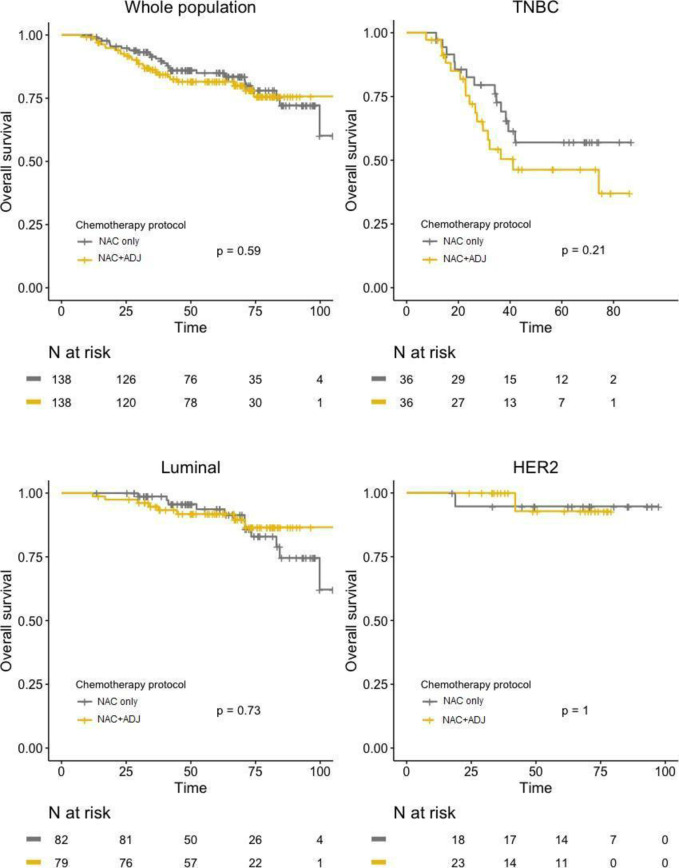
OS curves in NAC only and NAC+ADJ groups for whole population and by pathological subtype (TNBC, luminal, and HER2-positive tumors), after PS matching.